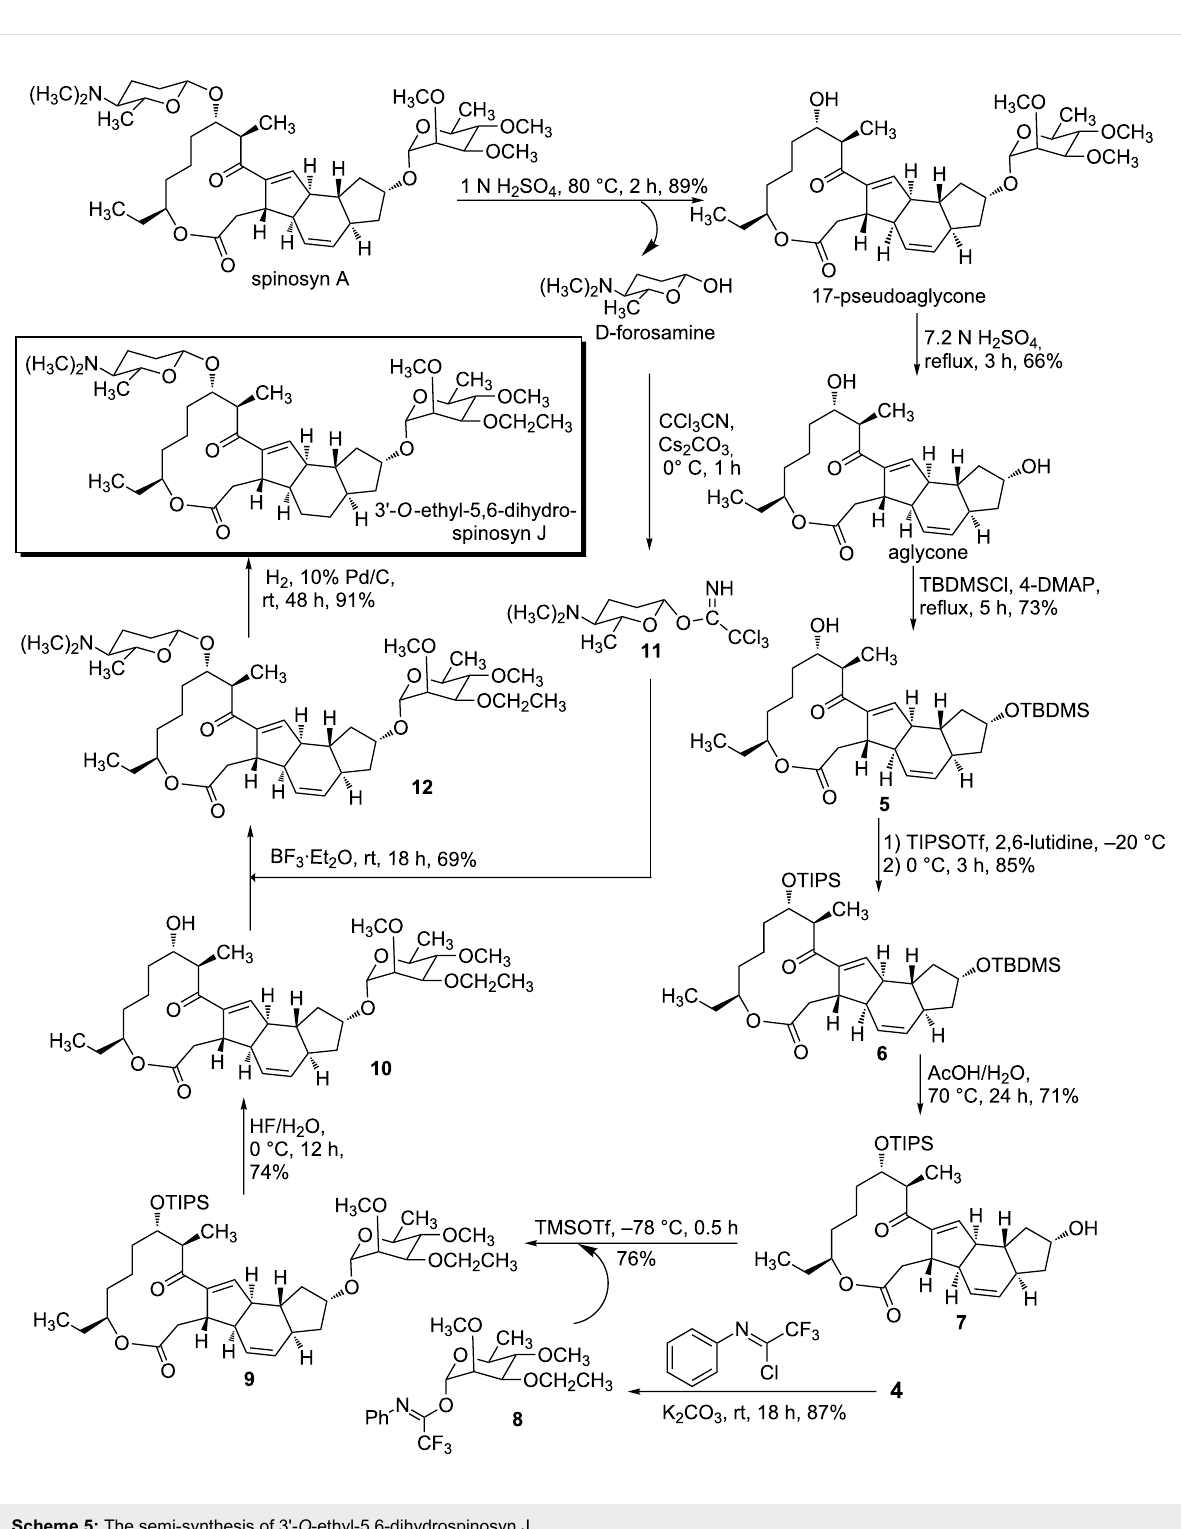
Scheme 5: The semi-synthesis of 3'- O -ethyl-5,6-dihydrospinosyn J.